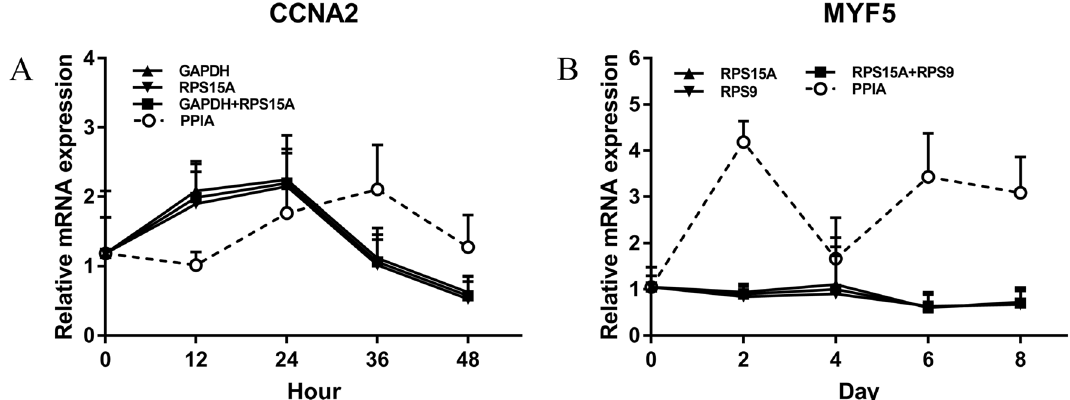
Figure 5. Effect of reference gene normalization on CCNA2 and MYF5 gene expression in bovine skeletal muscle-derived satellite cells. ( A ) Expression of CCNA2 during proliferation was normalized to the geometric means of GAPDH , RPS15A , PPIA and GAPDH + RPS15A . ( B ) Expression of MYF5 during the induced differentiation phase was normalized to the geometric means of RPS15A , RPS9 , PPIA , and RPS15A + RPS9